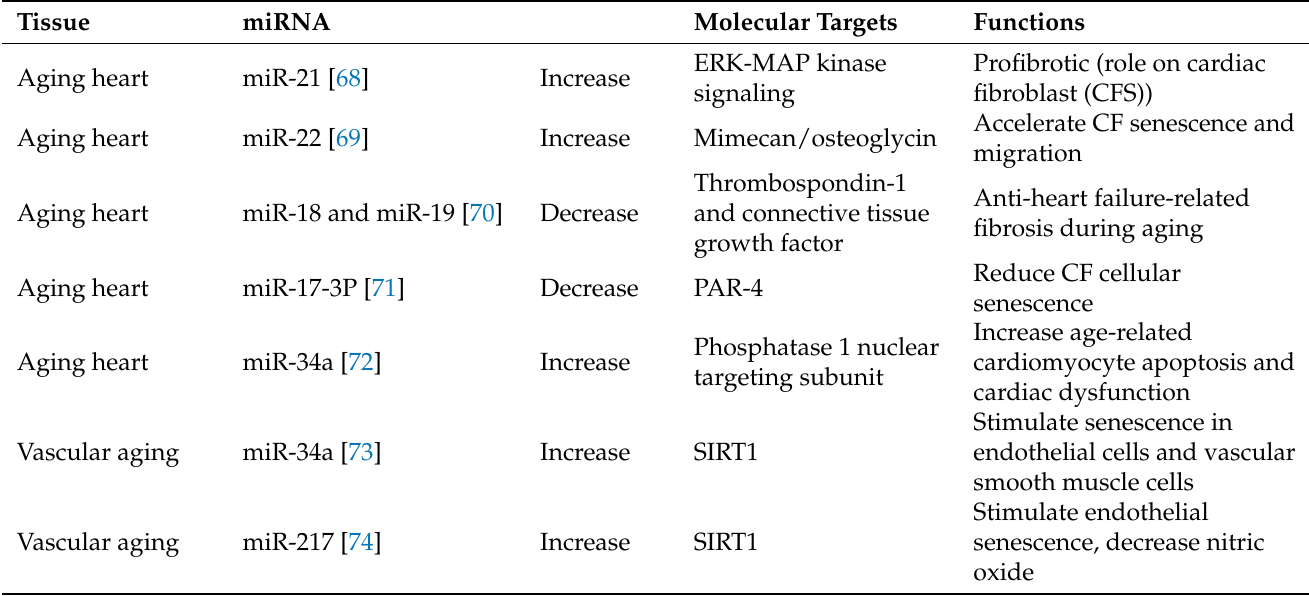
Table 1. Summary of microRNA (miRNA) involvement in cardiac and vascular